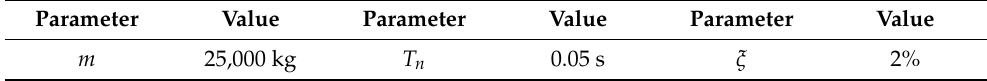
Table 1. Structure